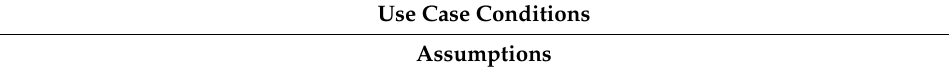
Table 3. Conditions/assumptions/prerequisites for the